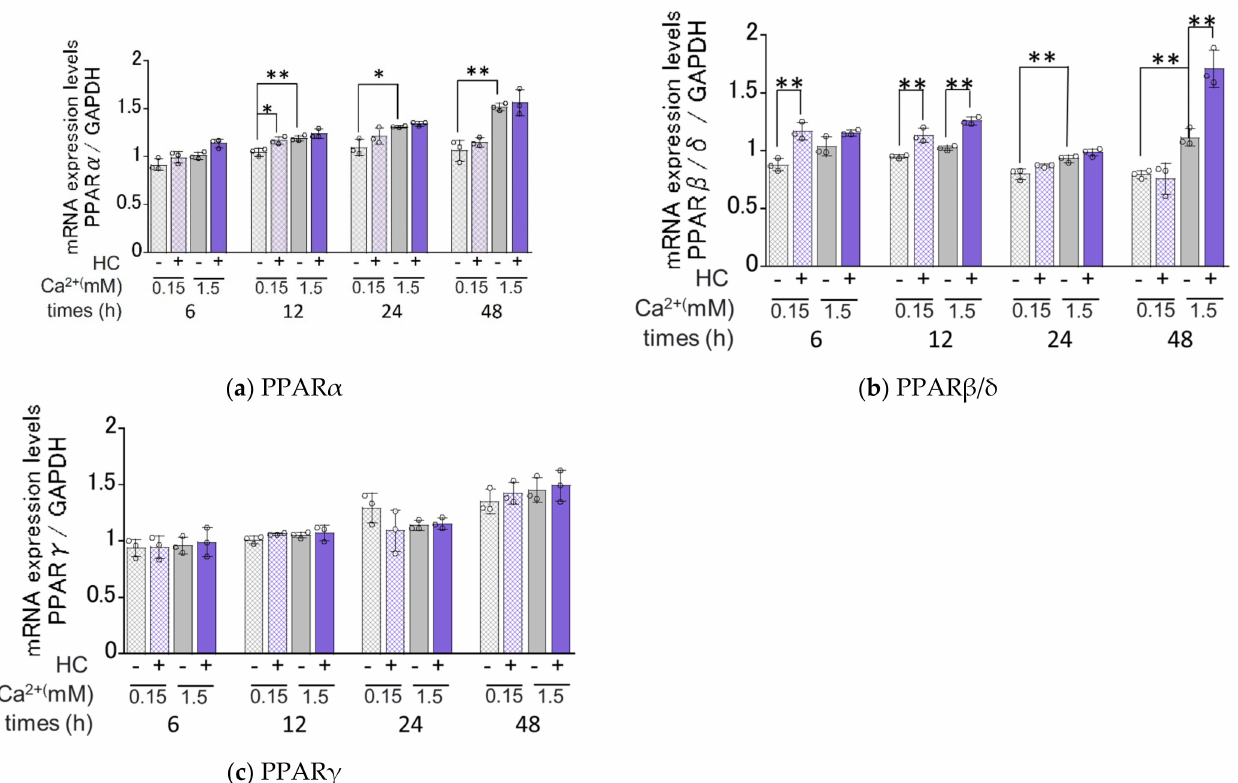
Figure 7. Effect of HC on the mRNA expression levels of PPARs under proliferating and differentiat- ing conditions of NHKs. ( a ) PPAR α , ( b ) PPAR β / δ , ( c ) PPAR γ . NHKs were treated with HC (at 0 or 200 µ g/mL) for 6, 12, 24 and 48 h in low-Ca 2+ or high-Ca 2+ conditions. Total RNAs were extracted as described in the Section 4 Materials and Methods. mRNA expression levels were determined by real-time RT-PCR and are expressed as each mRNA level/GAPDH. Bars represent mean ± SD, n = 3, Tukey–Kramer multiple comparison test. *: p < 0.05, **: p <